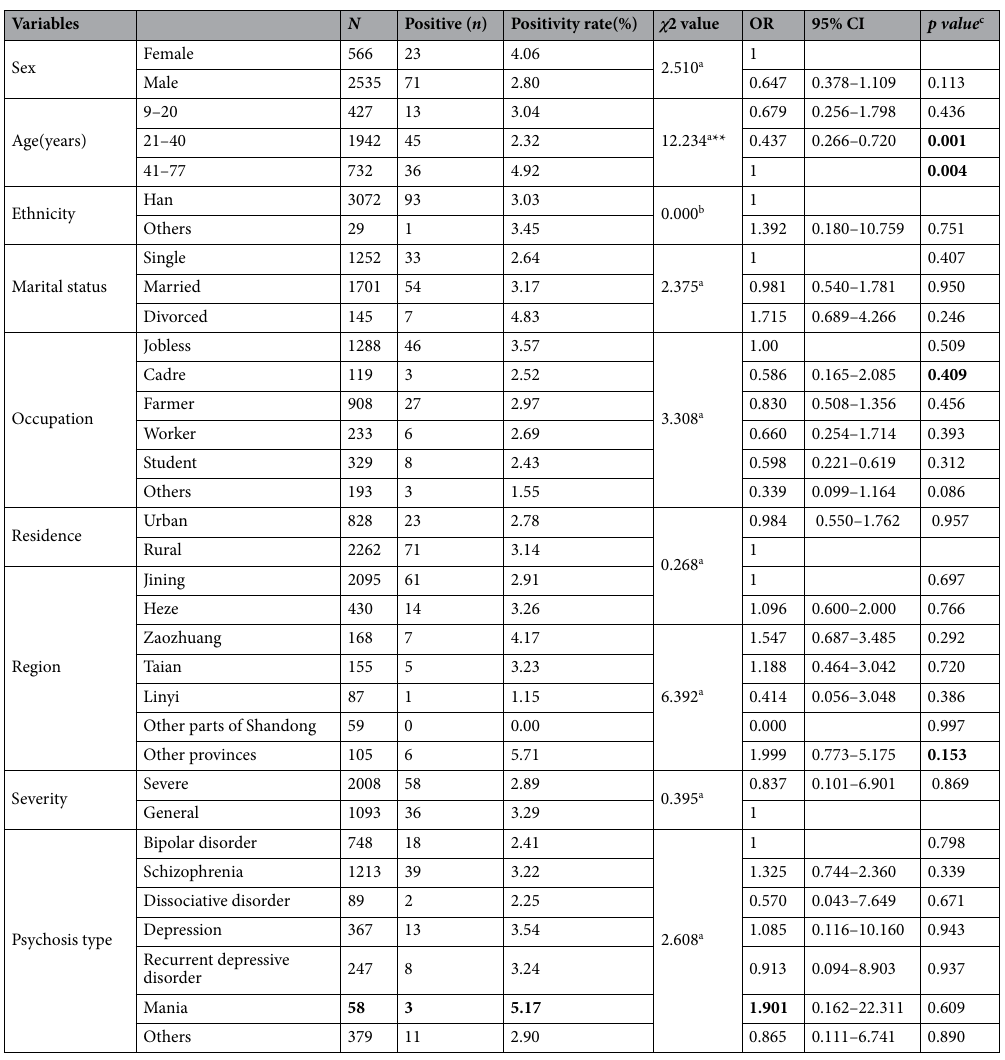
Table 3. Analysis of the seroprevalence of anti- Toxoplasma IgG antibody in psychiatric patients ( N = 3101). a Pearson chi-square test. b Fisher’s exact probability method. c Binary logistic regression analysis. ** p <